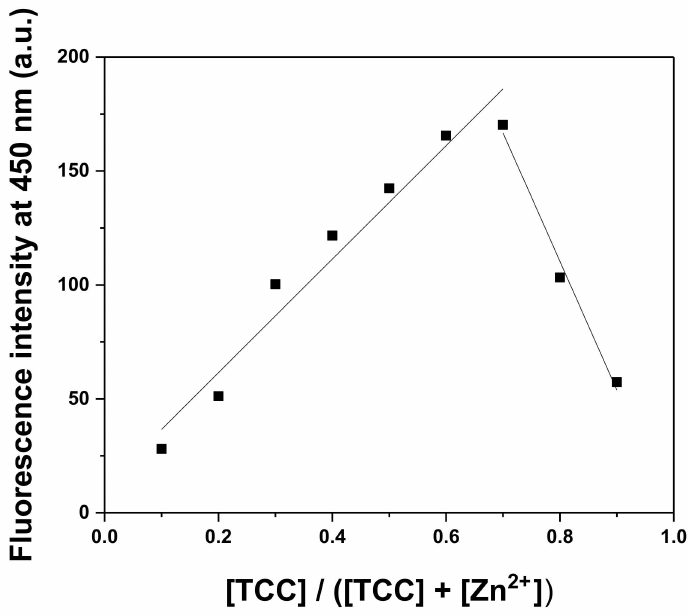
Figure 4. A Job plot for TCC with Zn 2+ ( λ ex = 320 nm).